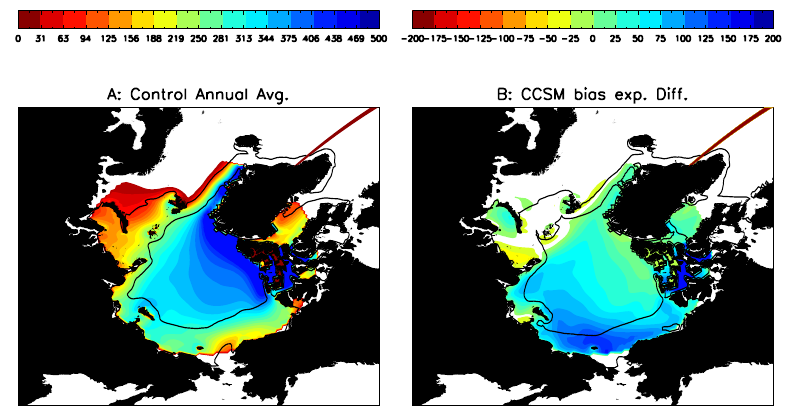
Fig. 7. Panel (a) : equilibrated ice thickness (cm) and 15% and 90% ice extent in September (black contours) for control run. Panels (b) : difference in ice thickness between CCSM bias experiment and the control run (cm) and 15% and 90% September ice extent (black contours).